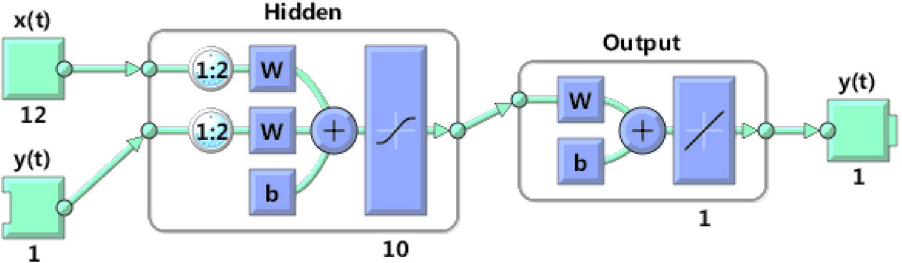
Figure 5. The frame structure of the LASSO-NARX model, where the input is the predicted value of the LASSO regression model and the measured value of the self-built point. This network has 12 inputs, 1 hidden layer with 10 hidden neurons, 2 input delay orders, and 1 linear output layer leading to 1